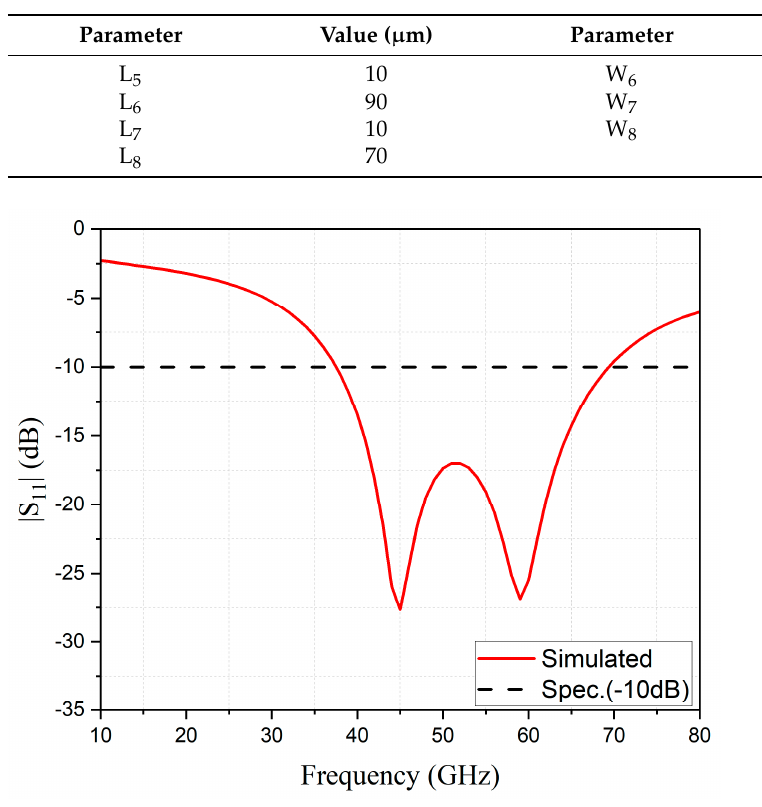
Table 2. The detailed value of the proposed AMC.